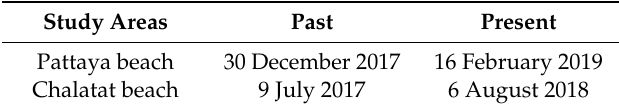
Table 1. Time series of satellite images from Google Earth.